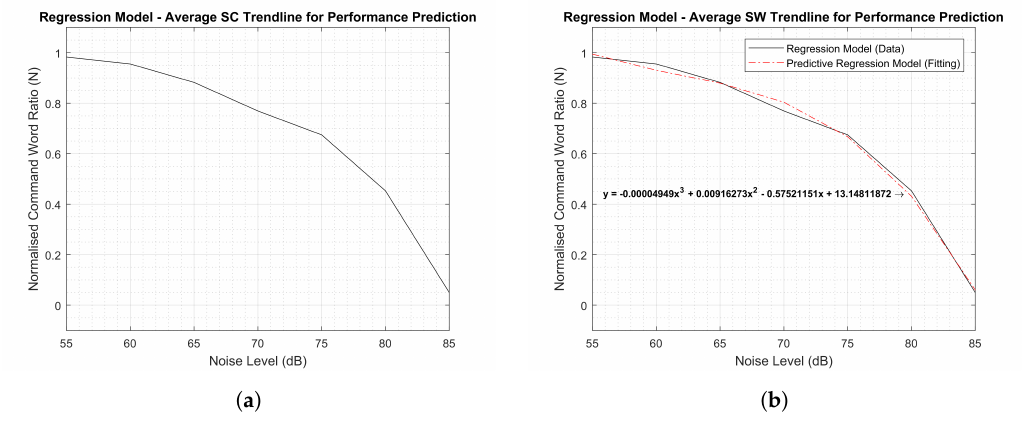
Figure 13. Modelling the SW trendline. ( a ) SW trendline model—normalised, ( b ) SW trendline predictive model